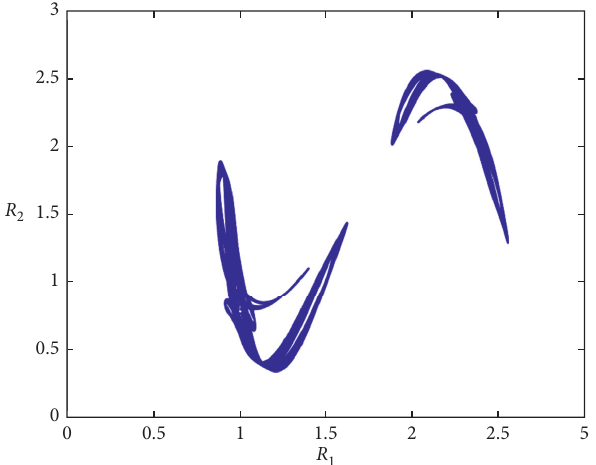
Figure 4: Strange attractor for u